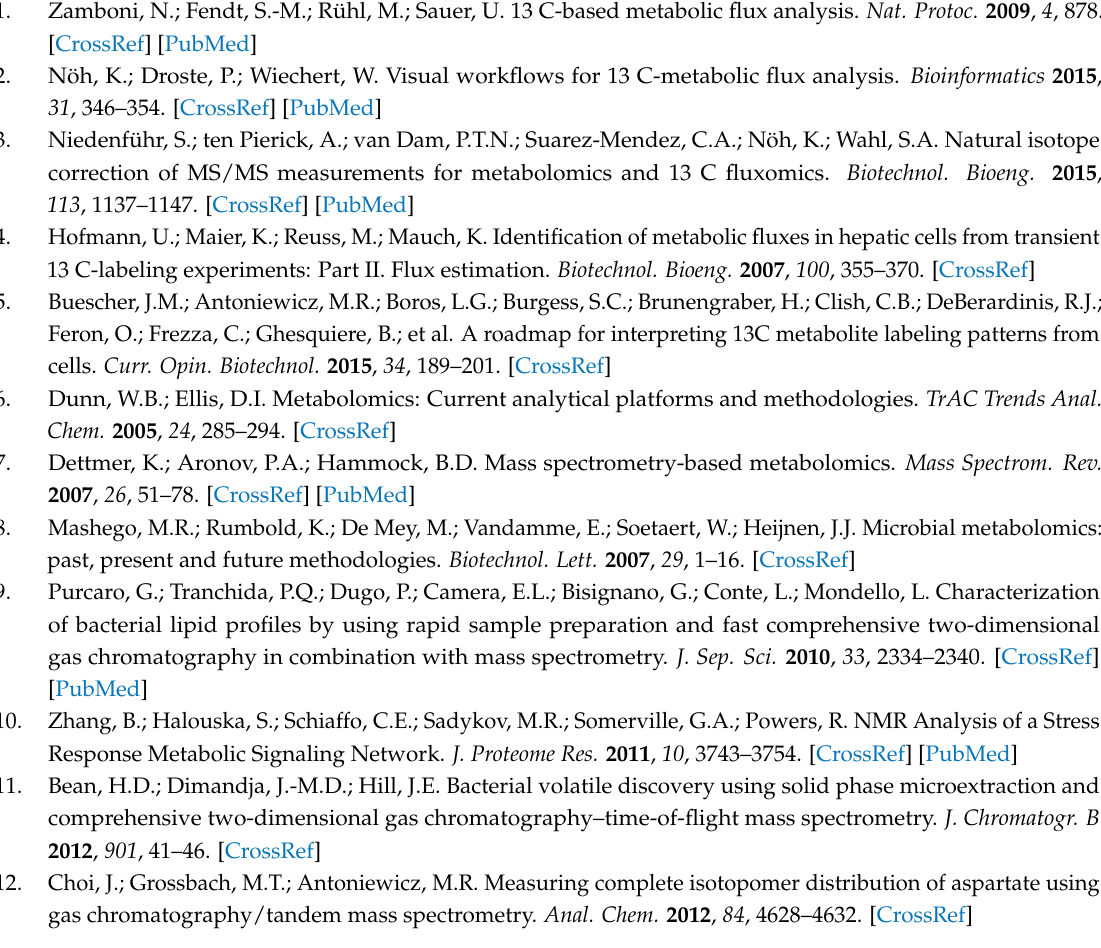
Table S1: QQQ-MS/MS Parameters (MRM Mode) and HILIC Program Settings for Targeted Metabolites and U 13 C-Analogs; Table S2: QTOF-HRMS and Extraction Parameters (MS Mode and EDR Tune) and HILIC Program Settings for Targeted Metabolites and U 13 C-Analogs; Table S3A,B: QQQ-MS/MS Parameters (SIM Mode) and HILIC Program Settings for Targeted Metabolites and Corresponding 13 C-Isotopologues; Table S4: QTOF-HRMS Parameters (MS Mode and HR Tune) and HILIC Program Settings for Targeted Metabolites and Corresponding 13 C-Isotopologues; Table S5: Regression parameters of HILIC-QQQ-MRM studies of direct and U13C-normalized (IDMS) metabolite-specific signal responsivities using short (up to 1 µ M) and extended calibration ranges (up to 400/800 µ M, 5 µ L sample injection). Supplementary details of Table 1. See Table 3 and Table S1–S4 for the full names of abbreviated metabolites. Table S6: Regression parameters of HILIC-QTOF-HRMS studies of direct and U13C-normalized (IDMS) metabolite-specific signal responsivities using short (up to 1 µ M) and extended calibration ranges (up to 400/800 µ M, 5 µ L sample injection). Supplementary details of Table 1. See Table 3 and Table S1–S4 for the full names of abbreviated